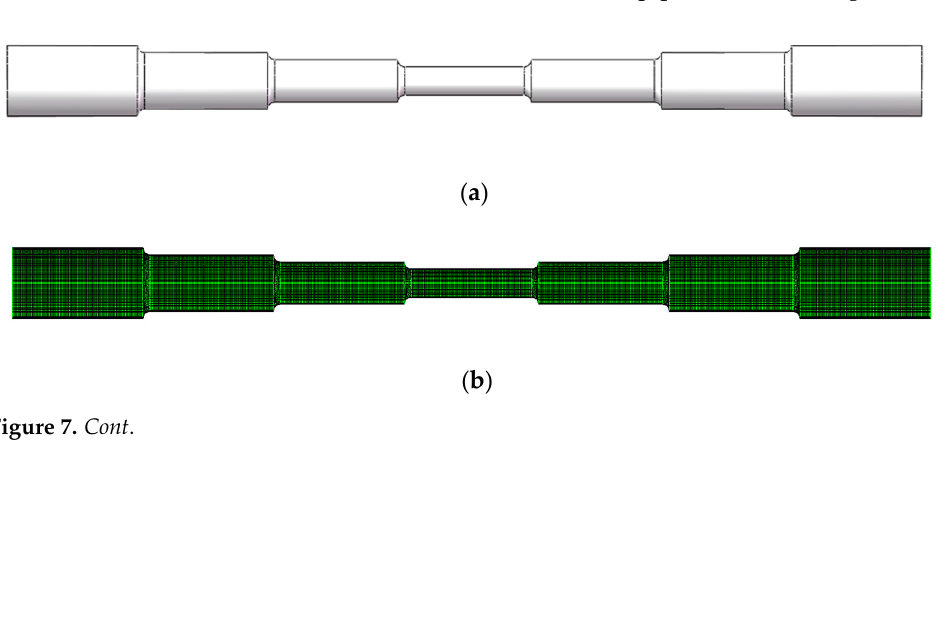
Table 2. Surface roughness Ra values.